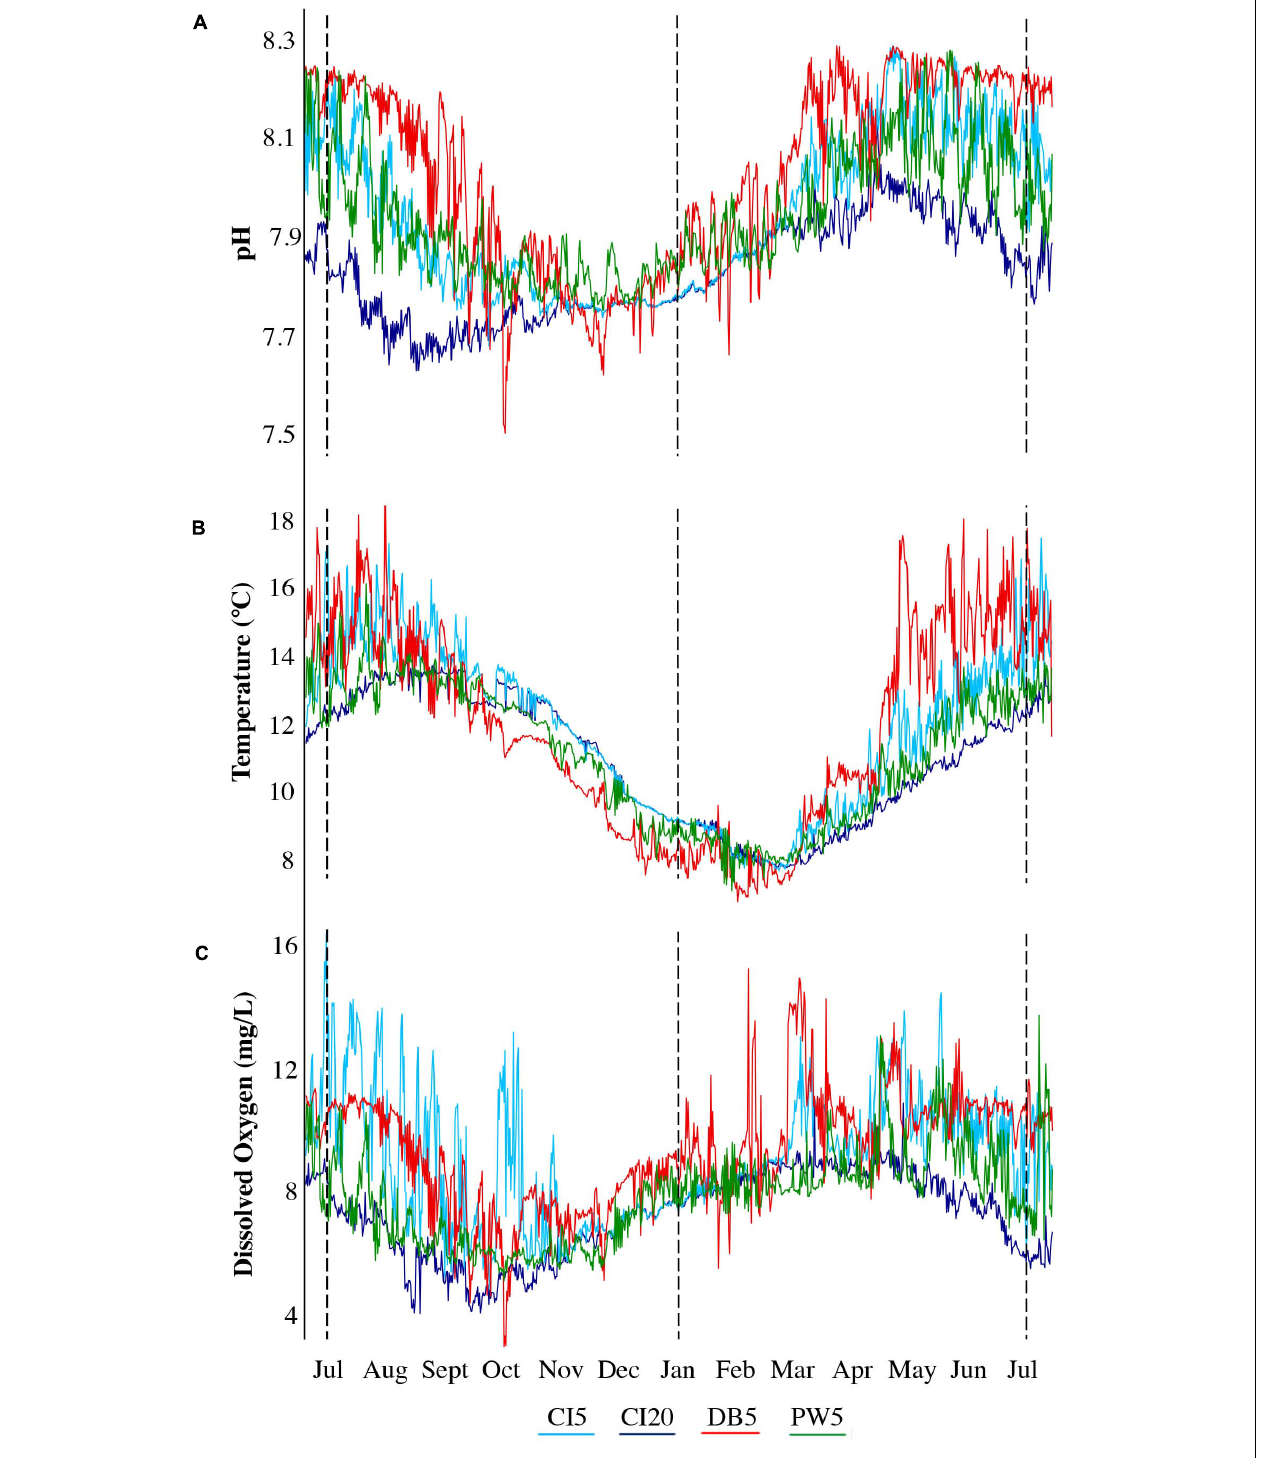
FIGURE 2 | Environmental data at the four shellfish cage locations from July 2018– July 2019 for (A) pH calculated using TIC and Alkalinity from Live Ocean Model data, (B) temperature (combination of ORCA buoy and Live Ocean Model Data), and (C) dissolved oxygen (combination of ORCA buoy and Live Ocean Model Data). Dotted vertical lines indicate approximately when the shellfish were deployed (July 2018), when the first shellfish samples were taken (January 2019), and when the final shellfish samples were taken (July 2019).